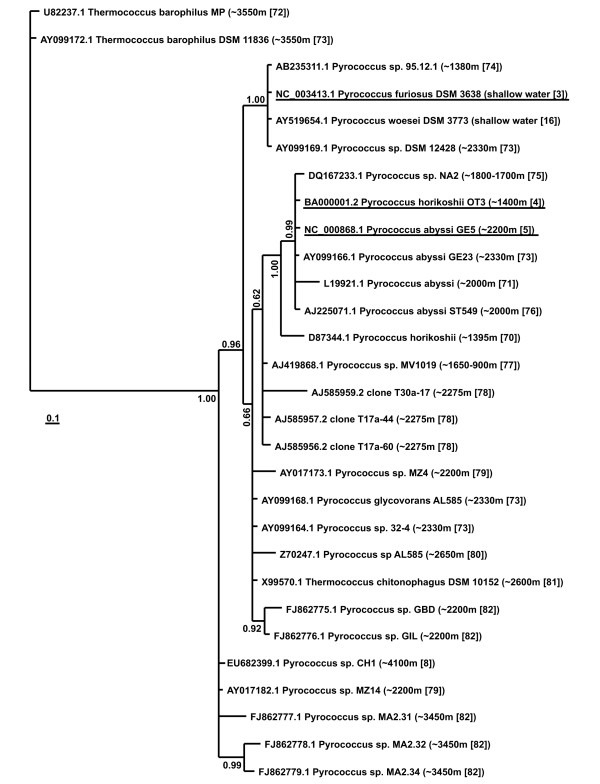
Phylogenetic relationships among Pyrococcus strains (from [3-5,8,16,70-82]) based on the 16S rRNA gene sequences. Bayesian posterior probabilities of nodes are shown.